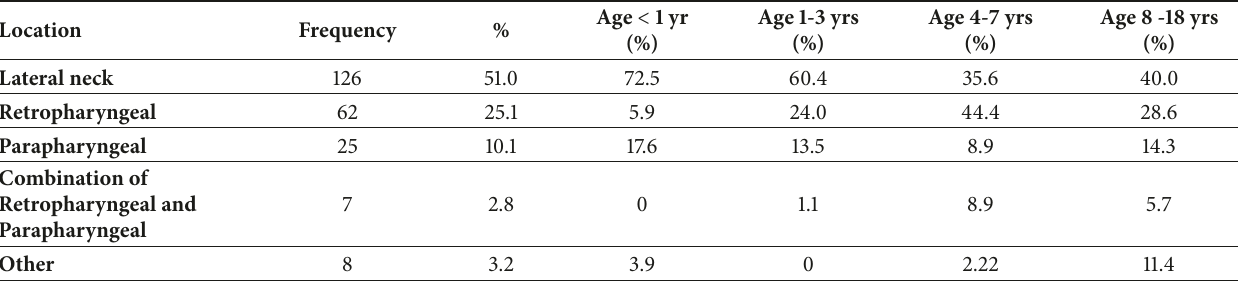
Table 4: Location of abscess.